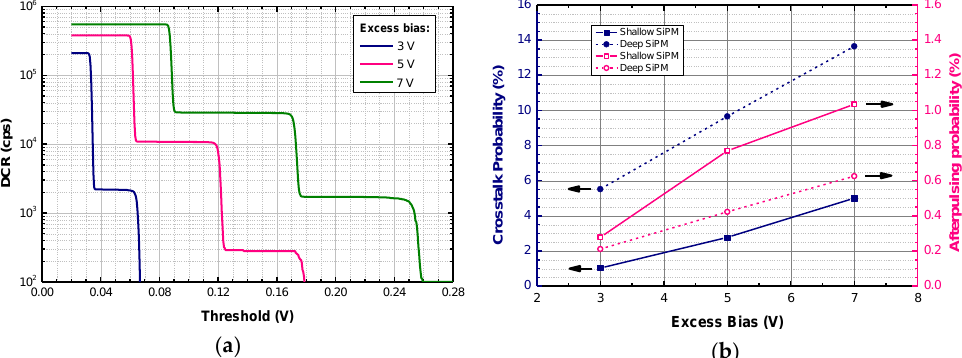
Figure 6. ( a ) Room temperature DCR as a function of discrimination threshold for a shallow SiPM at different excess bias; ( b ) Crosstalk and afterpulsing probability of shallow and deep SiPMs as a function of excess bias.